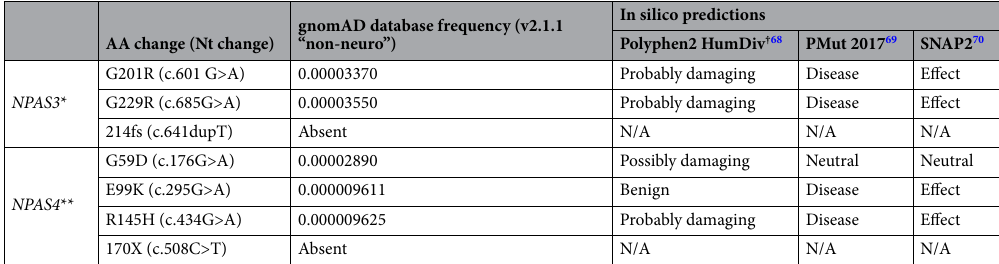
Table 1. Variant frequency and in silico predictions. * NPAS3 refseq: NM_001164749.2; ** NPAS4 ref seq: NM_178864.4; † Probably Damaging > Possibly Damaging > Benign. AA —amino acid, N/A —not applicable, Nt